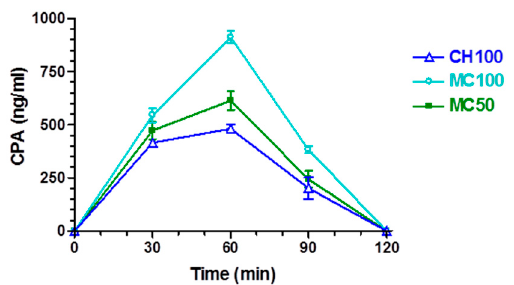
Figure 7. CPA concentrations (ng/mL) detected in the cerebrospinal fluid (CSF) after nasal administration of CH100, MC100 and MC50. Data are expressed as the mean ± standard deviation, n = 4.